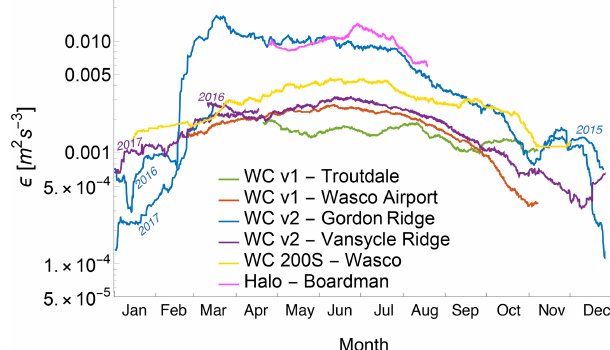
Figure 8. Low-pass-filtered (with a 15-day moving average) time series of (cid:15) from the four considered profiling lidars and the two scanning lidars as a function of the calendar day at